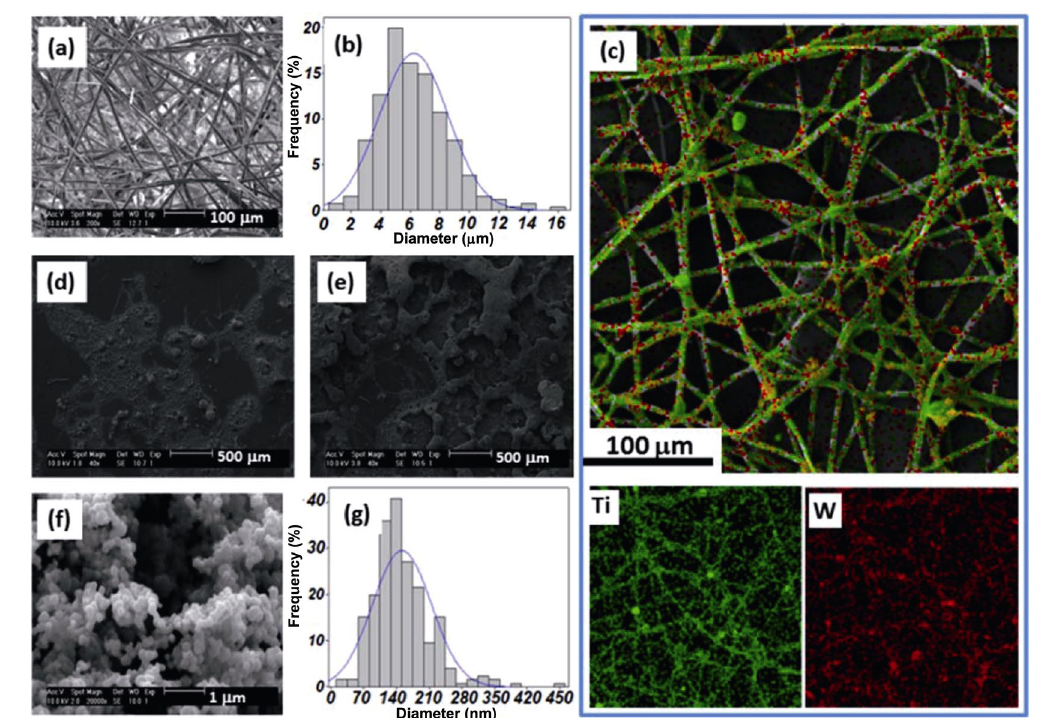
Fig. 2 (a) SEM image of the (TiO 2 /WO 3 )-loaded fibers and (b) their respective diameter distribution and (c) EDS mapping, before sintering; top view micrographs of the systems prepared with (d) one and (e) three layers, after sintering; (f) SEM image of the sintered TiO 2 /WO 3 structures and (g) their diameter distribution of